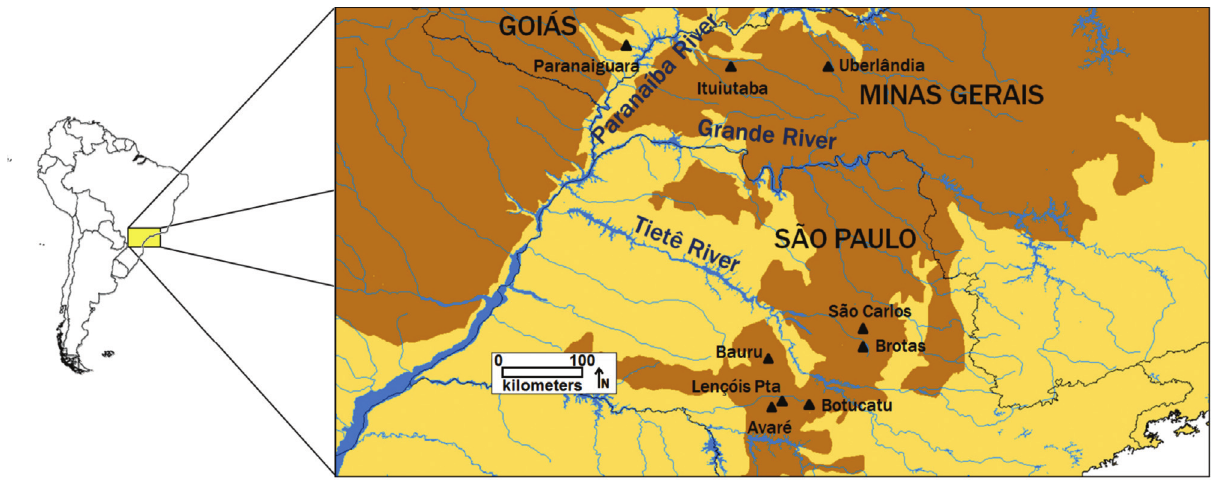
Figure 1 - Localities analyzed . Localities sampled during the present study, located within the Cerrado biome (brown shading) in relation to the major lo- cal rivers, the Paranaíba, Grande, and Tietê. Shown are the original limits of the Cerrado biome, that is, prior to recent anthropogenic